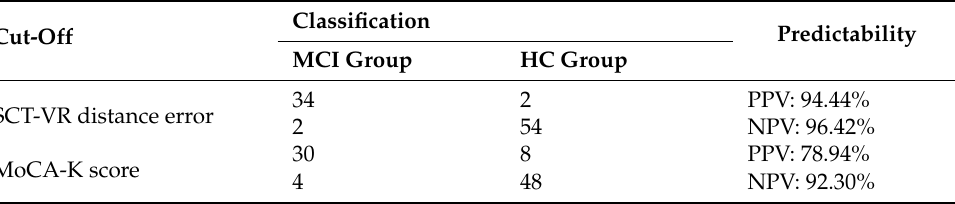
Table 7. Comparison between PPV and NPV based on the cut-off between the SCT-VR and the MoCA-K ( n =